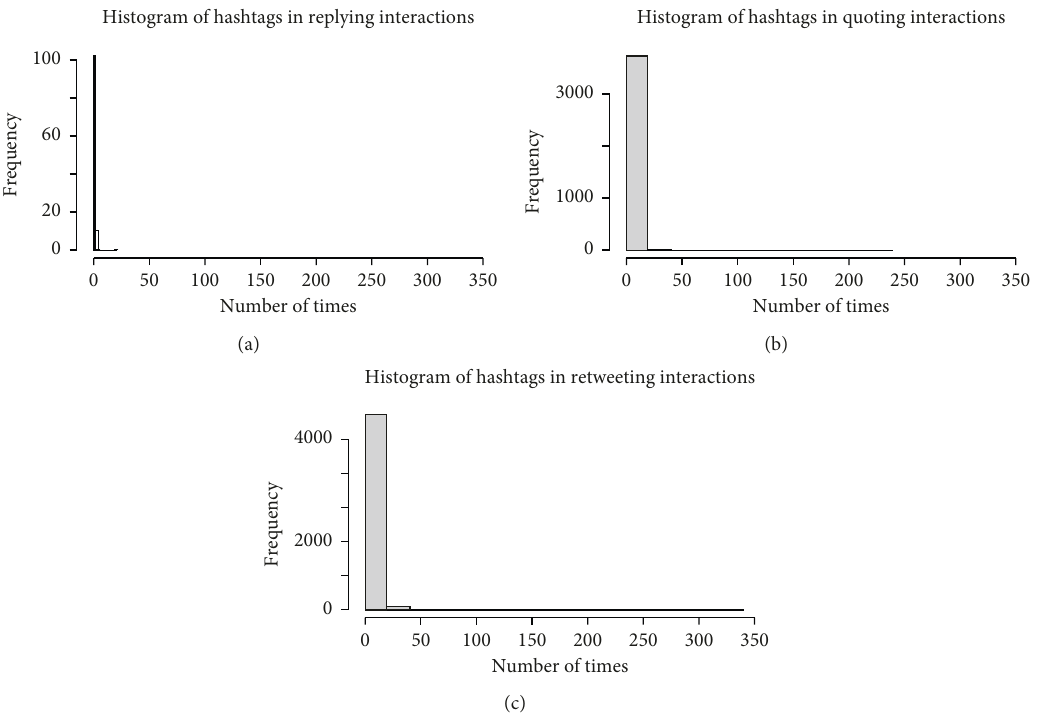
Figure 6: For replying (a), retweeting (b), and quoting (c) interactions, histograms of hashtags.